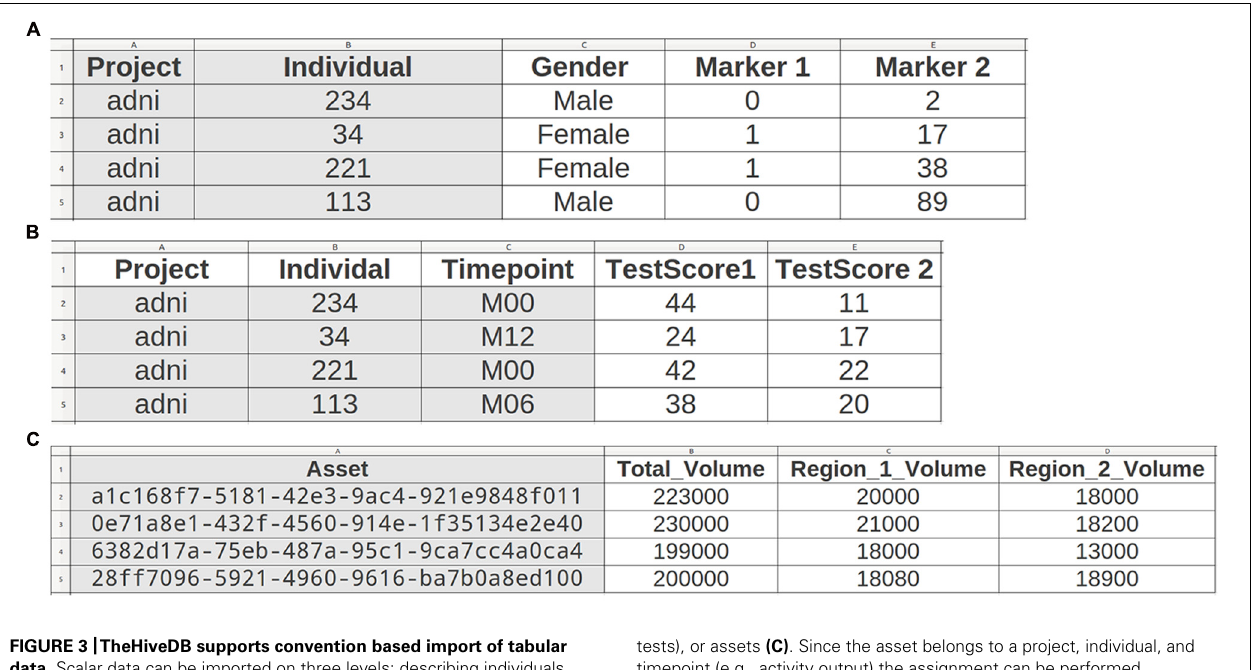
tests), or assets (C) . Since the asset belongs to a project, individual, and timepoint (e.g., activity output) the assignment can be performed automatically by just providing the unique asset